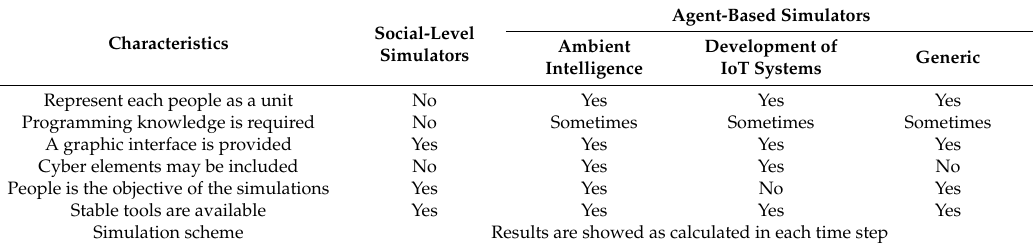
Table 3. Social simulators comparison.